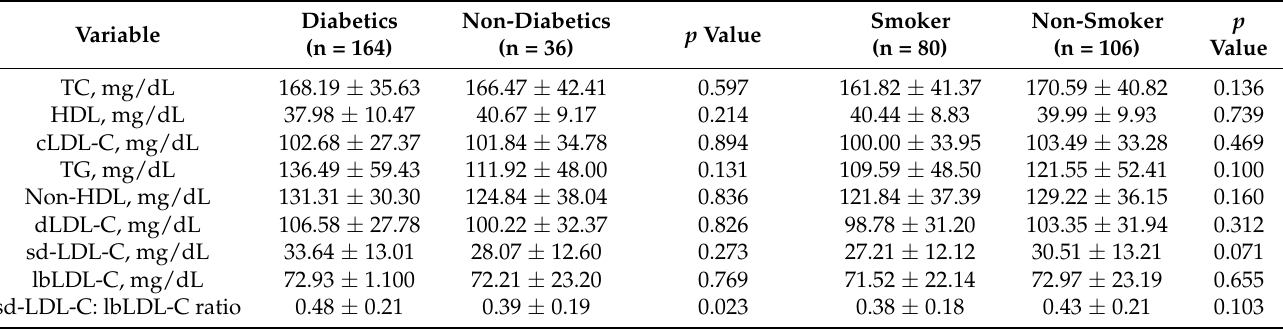
Table 4. Lipid profile comparison between diabetics versus non-diabetics and smokers versus non-smokers.